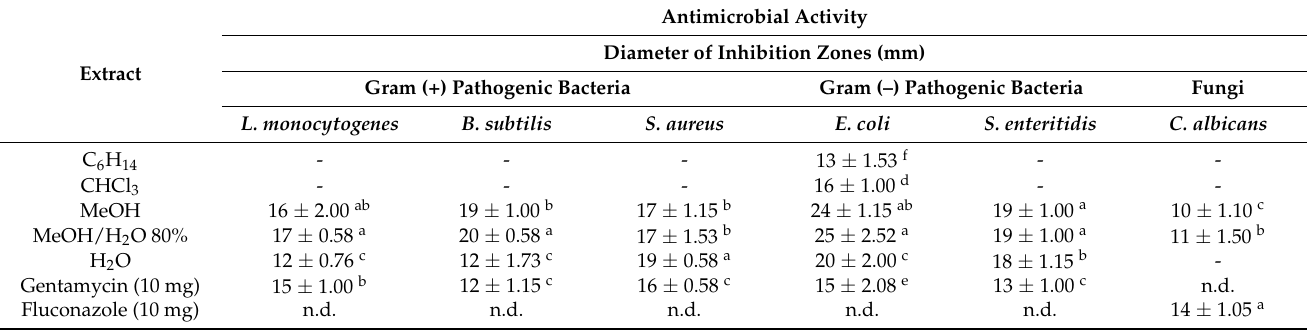
Antimicrobial Activity Diameter of Inhibition Zones